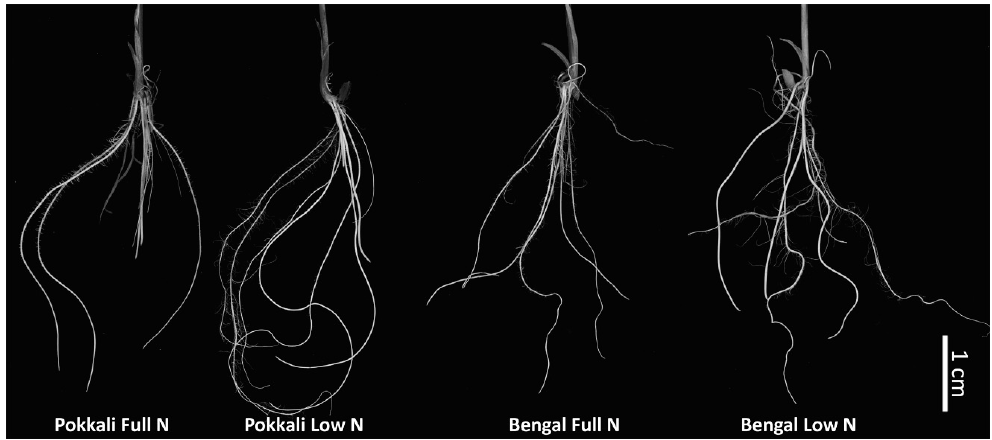
Figure 3. Root architectures of Pokkali and Bengal seedlings under low and full nitrogen treatment.